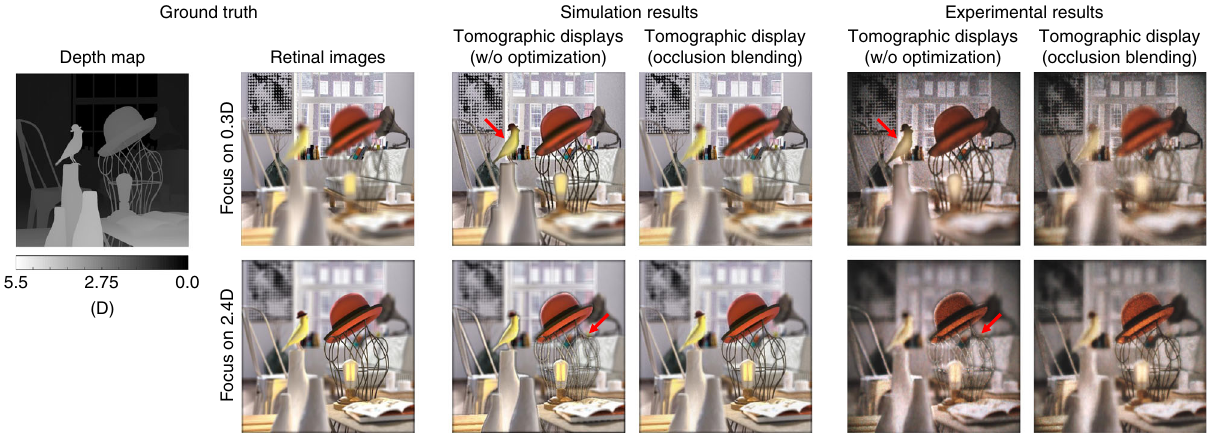
Fig. 3 Simulation and experimental results demonstrating occlusion blending. A volumetric scene (Source image courtesy: “ Interior Scene ” , www.cgtrader. com) extends along the depth range between 0.0D and 4.0D. As shown in the fi gure, occlusion blending enables tomographic displays to represent volumetric scenes without noticeable artifacts even at the occlusion boundary (red arrows). Additional experimental results are available in Supplementary Note 2